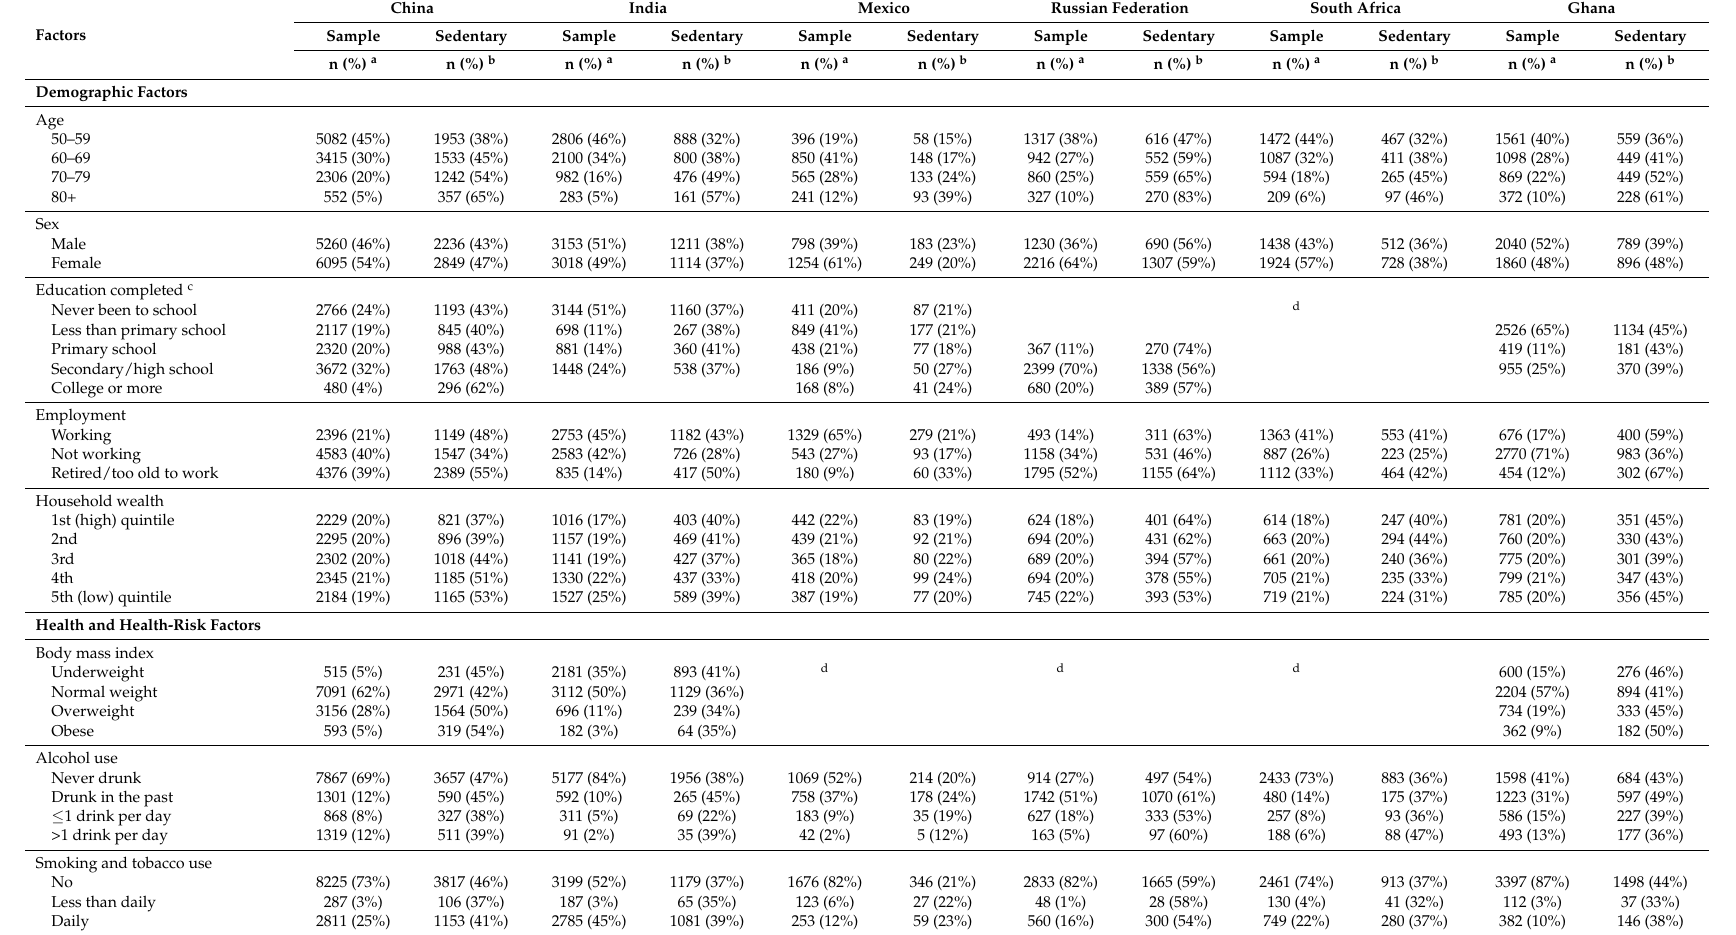
Table 3. Descriptive statistics for the samples of adults and for those who were sedentary ≥ 4